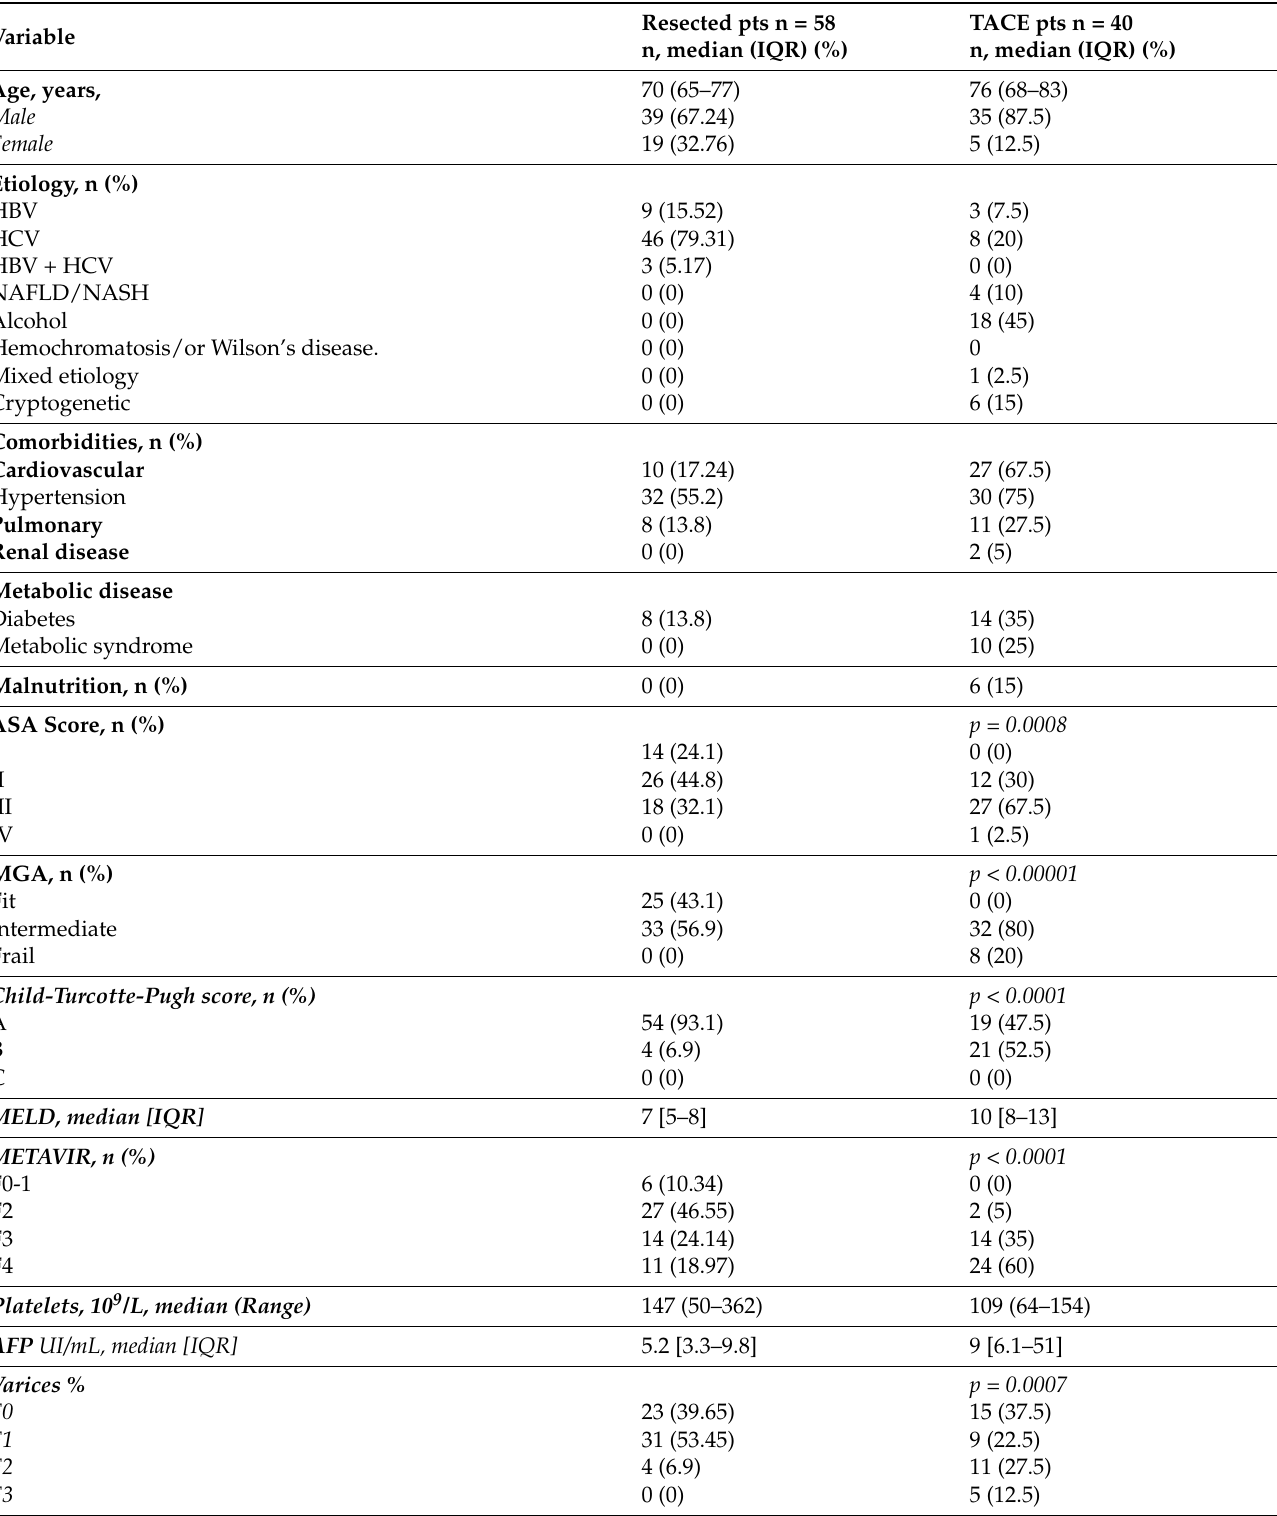
Table 4. BCLC-B patients of our cohort vs. a cohort of 40 patients. Baseline